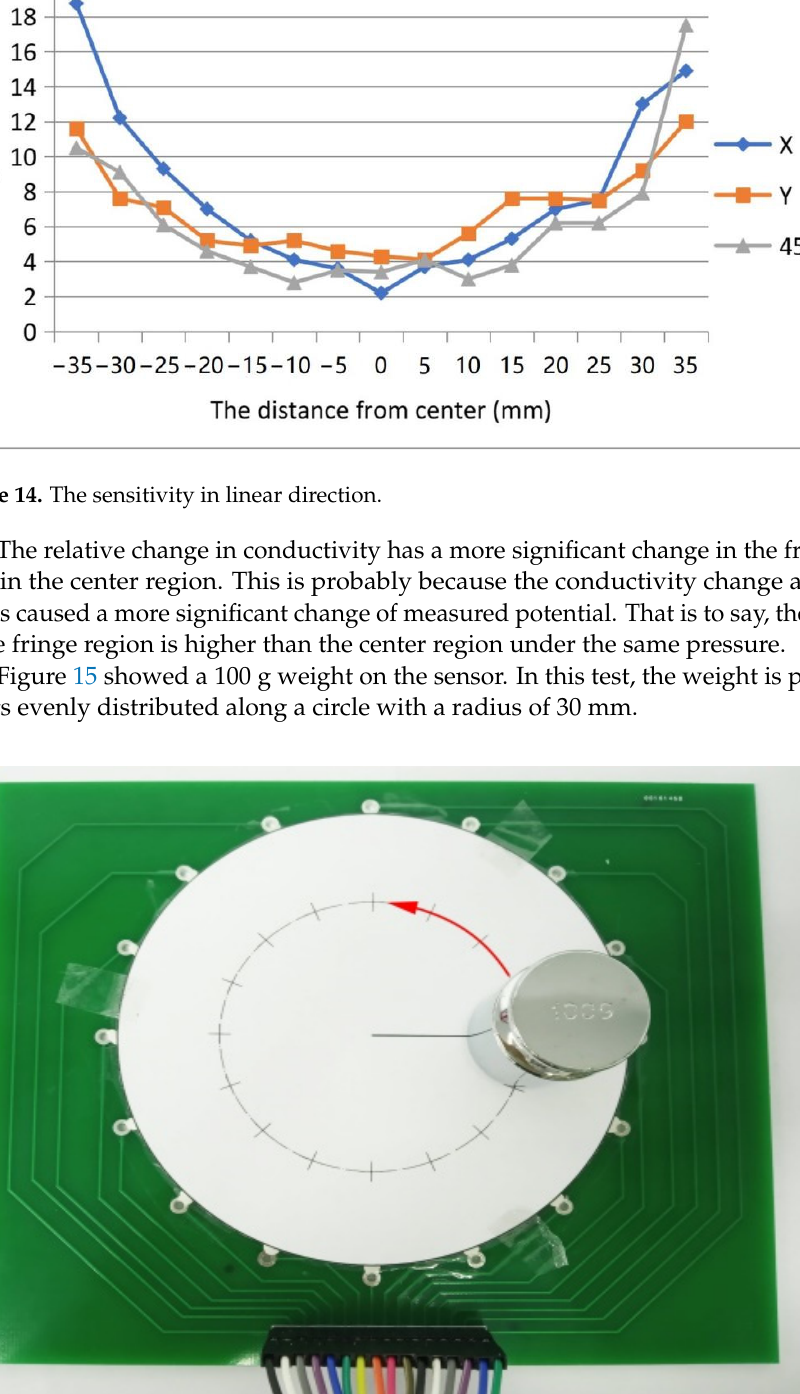
Figure 15. Setup to detect the sensitivity in circular direction.